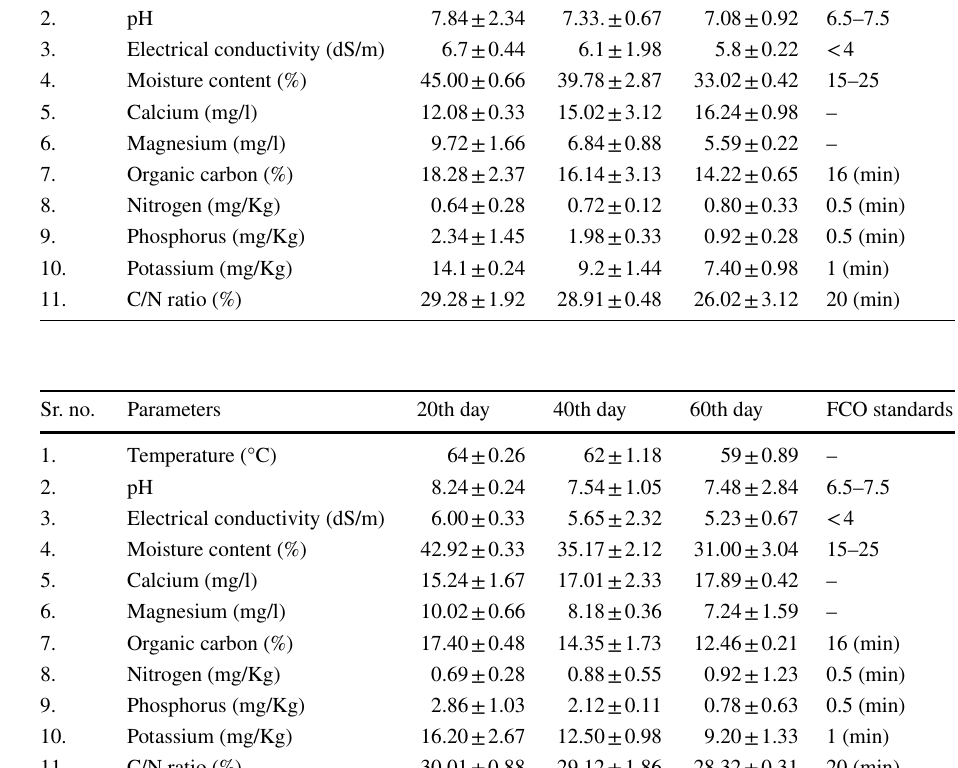
characterization of compost in Solan (H.P.)